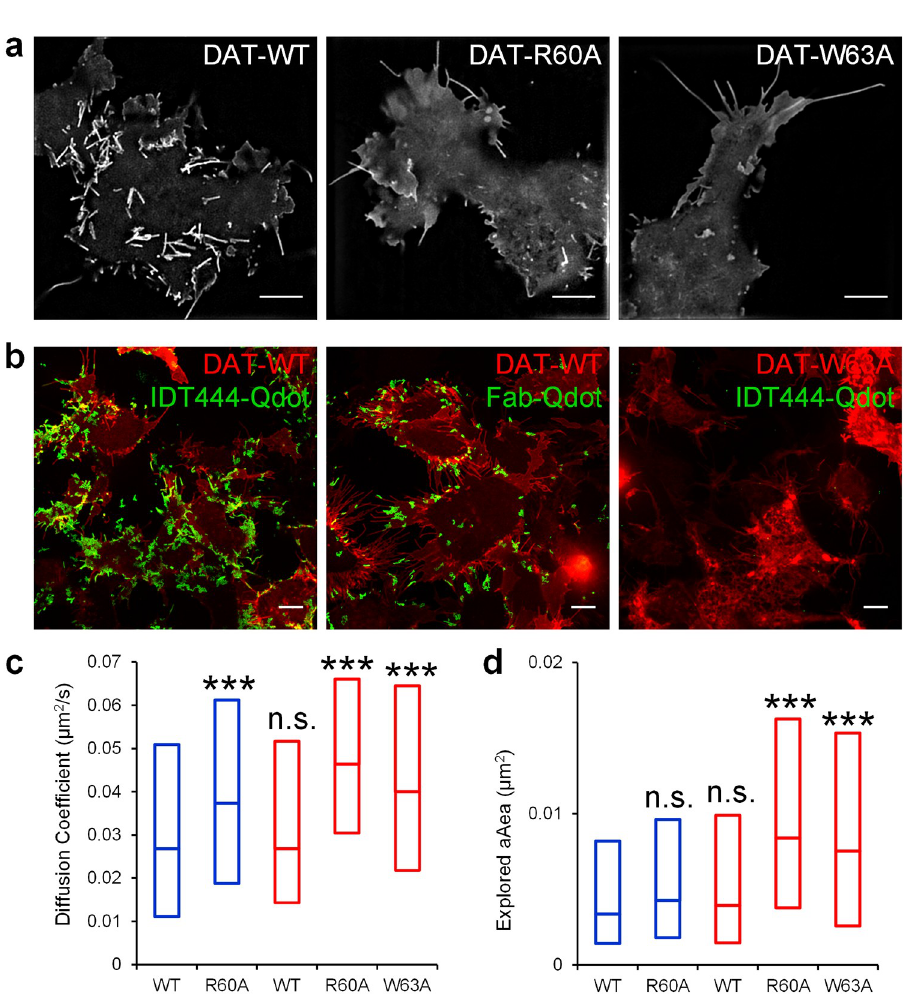
Fig 7. Effects of DAT conformation state on DAT membrane distribution and diffusion dynamics. (a) SIM superresolution images of RFP-HA-DAT, YFP-HA-DAT-R60A, and YFP-HA-DAT-W63A distribution. Scale bar: 5 μ m. Images are representative of at least three independent experiments. Two MatTek dishes plated per passage with three to six 512x512 fields of view acquired per MatTek dish constituted an independent experiment. (b) Representative 60-s MIP trajectories of DAT-Qdots labeled either with biotinylated IDT444 (left) or anti-HA-biotin Fab (center) are shown. Note the lack of Qdot labeling of the dysfunctional, inward-facing W63A DAT variant (right). Scale bar: 10 μ m. (c and d) Analysis of the diffusion dynamics of WT DAT and its R60A and W63A dysfunctional variants. For IDT444-labeled (blue) transporter: N WT = 2861 tracks, N R60A = 1480 tracks; for anti-HA-biotin-tagged (red) transporter: N WT = 669 tracks, N R60A = 445 tracks, N W63A = 533 tracks. ��� p < 0.001, Kolmogorov-Smirnov test and one-way ANOVA with Dunnett’s post-hoc test. Median values and 25–75% interquartile ranges are tabulated in Table 2. Source data are provided in S2